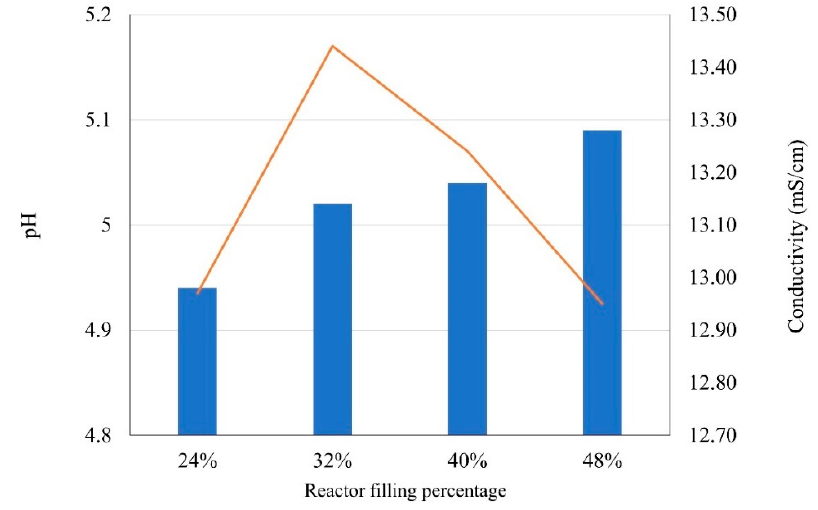
Figure 5. pH and conductivity for different filling percentages of the HTC reactor.